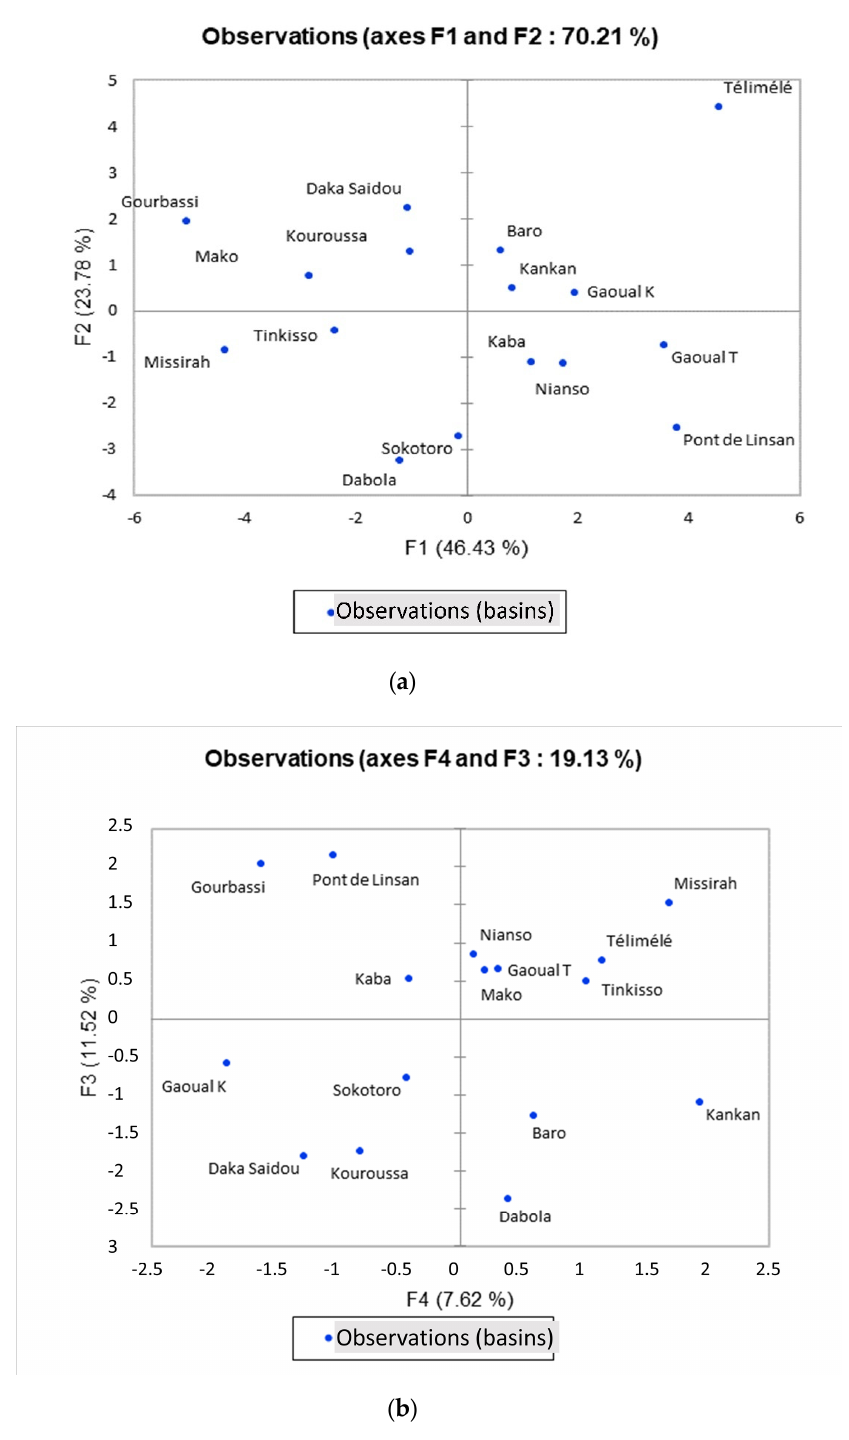
Figure 13. Observations spaces of the PCA analysis; ( a ): components 1 and 2; ( b ) components 3 and 4.